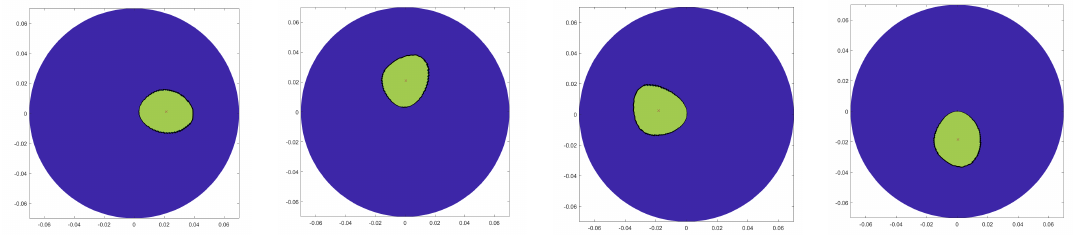
Figure 4. Ideal polyshape image using measured data for inclusion at 0 ◦ , 90 ◦ , 180 ◦ , and 270 ◦ ,